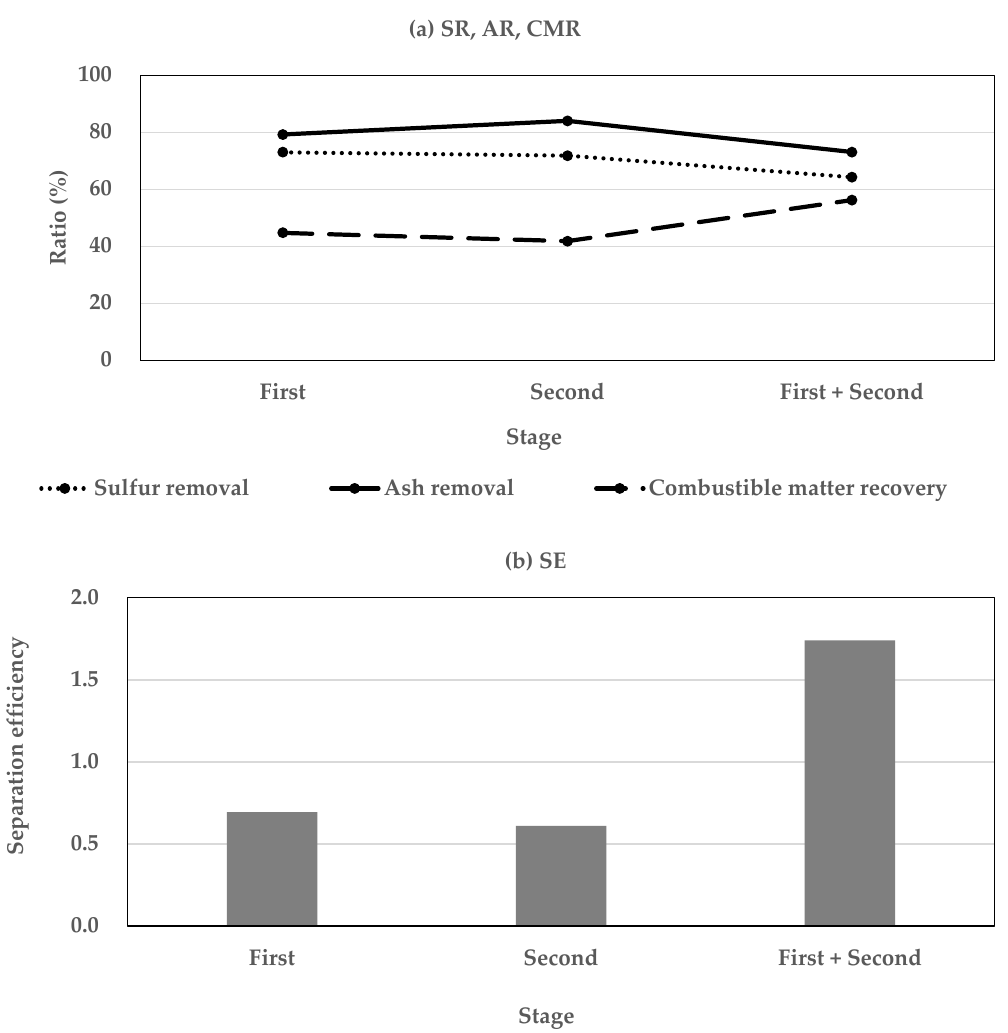
Figure 10. Performance of two-stage coal cleaning: ( a ) ash removal ratio (%), sulfur removal ratio (%), and combustible matter recovery ratio (%); ( b ) efficiency of coal separation using a dry coal cleaning system with two-stage corona electrostatic processes.